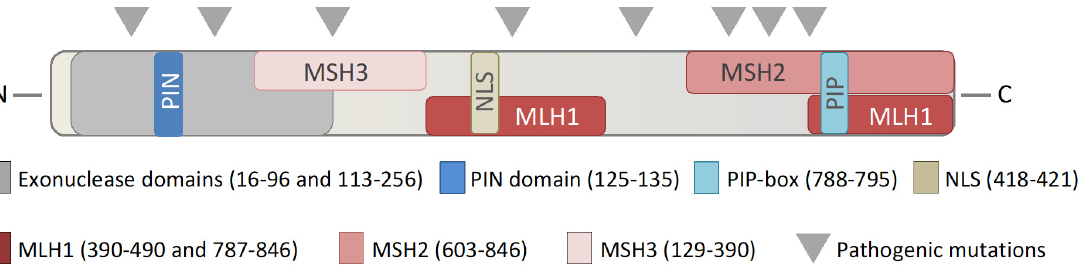
Figure 2. Interaction domains in EXO1. Schematic overview of the relevant interaction domains in the human EXO1 protein, denoting interaction domains with mismatch repair proteins MSH3, MLH1, MSH2, and other significant interaction regions, including with PARP1, PCNA, and the nuclear localization signal (NLS).